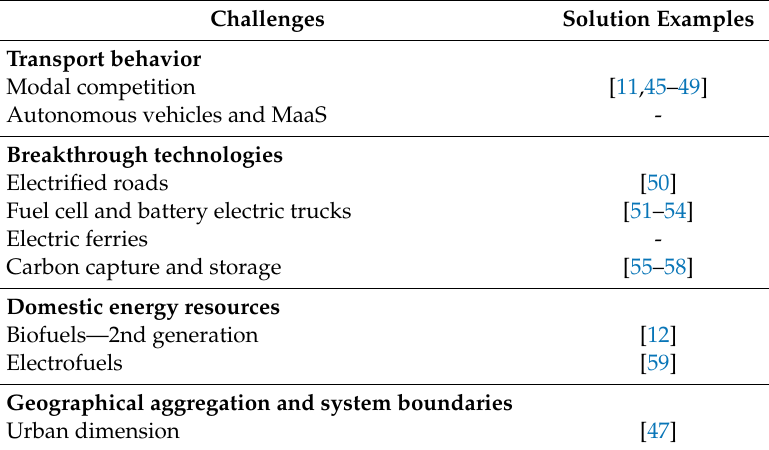
Table 1. Examples of studies tackling the identified challenges in their